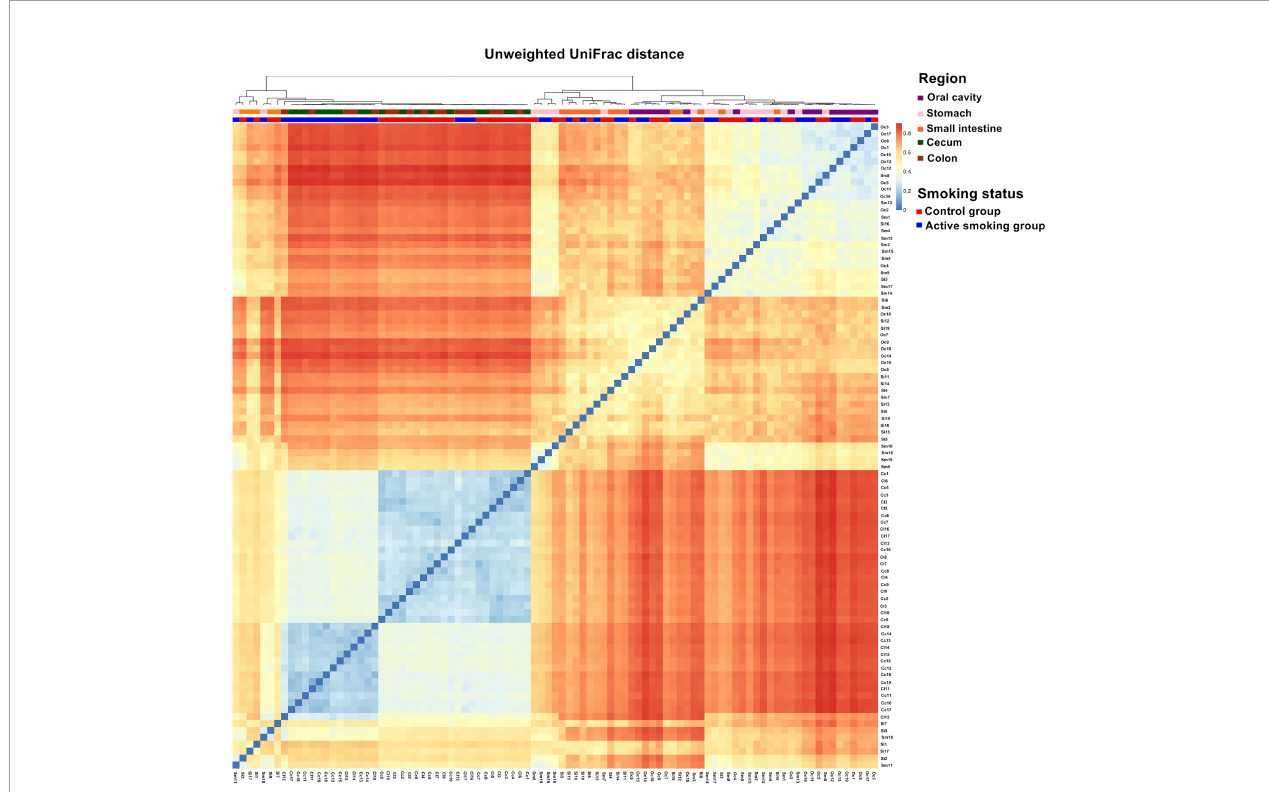
FIGURE 4 | Matrix heatmap based on phylogenetic unweighted UniFrac distance displays the overall community structure differences along the digestive tract according to active smoking status. Distinctive clustering in the control group and active smoking group is visualized in the cecal and colonic bacterial communities.